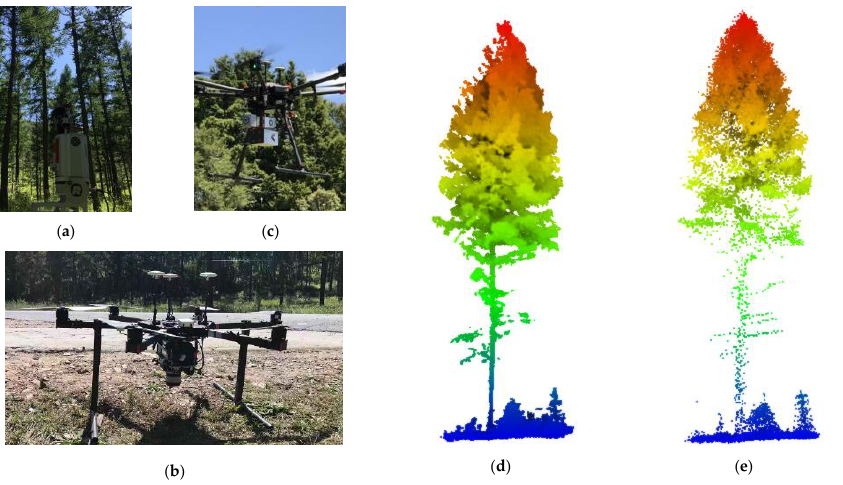
Figure 1. Various platforms and examples of one tree point cloud, ( a ) represents the terrestrial laser scanning(TLS) platform, ( b ) represents the unmanned aerial vehicle(UAV) LiDAR platform, and ( c ) represents the unmanned aerial vehicle(UAV) platform carrying with a digital camera, ( d , e ) represent the TLS point cloud and UAV LiDAR point cloud of one tree, respectively. a six-rotor UAV platform. The UAV integrated a GNSS-IMU system and a LiDAR scanner with a scanning field-of-view of 360°. The five-returns-per-pulse system was operated at